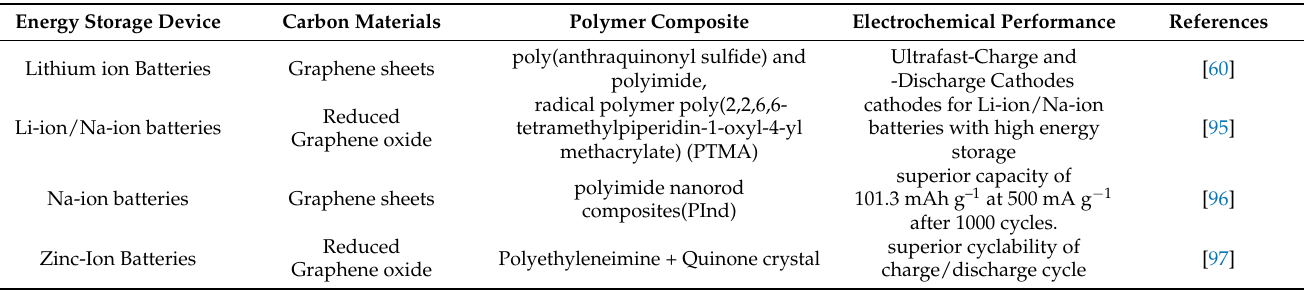
Table 1. Graphene polymer nanocomposites for